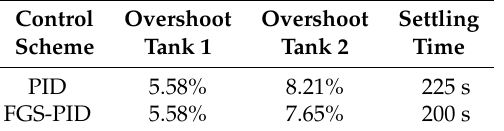
Table 5. Simulation results of the controllers’ transient response.